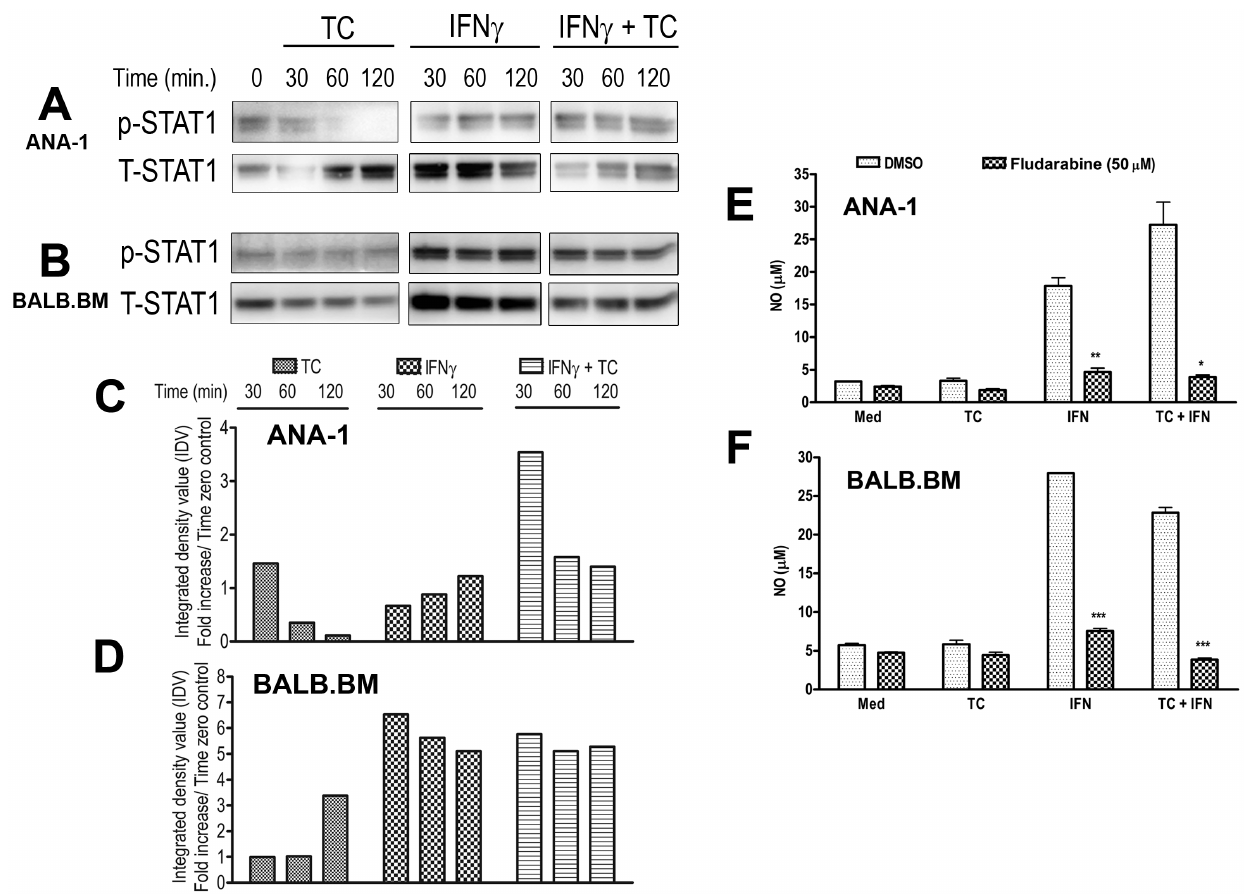
Figure 5. STAT1 regulates T.congolense WCE and IFN- c -induced NO release in both ANA-1 and BALB.BM cells. Serum-deprived ANA-1 ( A , C , E ) and BALB.BM ( B , D , F ) macrophage cell lines were stimulated with TC, IFN- c or both to assess STAT1 phosphorylation ( A , B ), also shown quantitatively in C , and D . In parallel, some cells were incubated with 50 m M STAT1 inhibitor (Fludarabine) prior to stimulation with IFN- c and TC in combination or alone; and nitric oxide (NO) release was measured in supernatants by Greiss’ assay. Data presented are representative of 3 different experiments with similar findings. *, p , 0.05; **, p , 0.01; ***, p , 0.001 compared to respective stimulated cells with DMSO (vehicle).